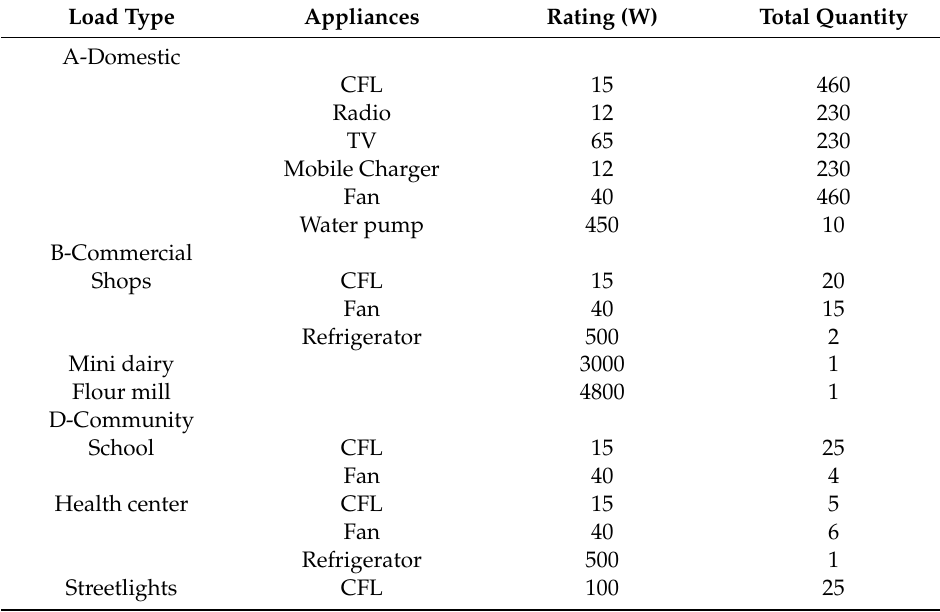
Table 2. Rating of appliances required for different sectors of electricity consumption.